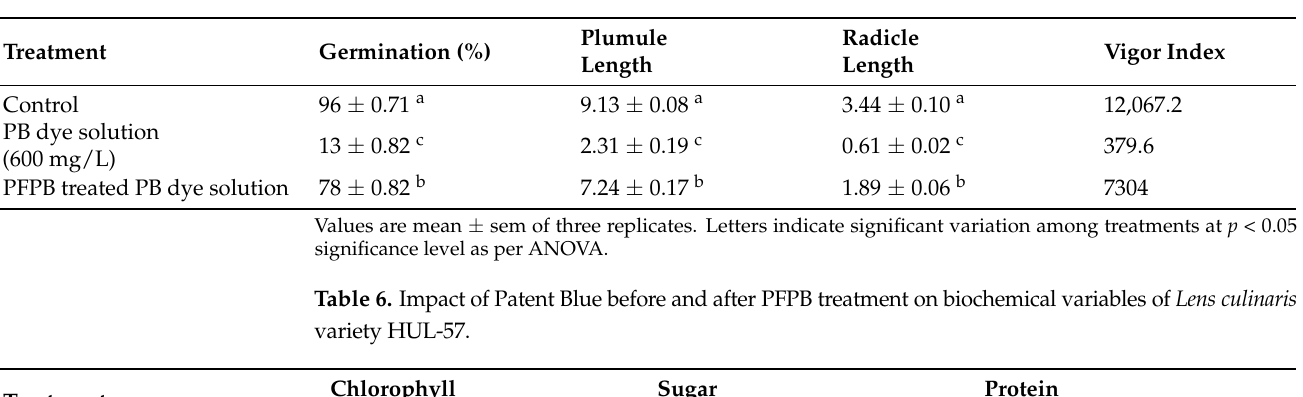
Figure 7. Patent Blue dye elimination by pineapple fruit peel biochar for up to five successive cycles. Table 5. Impact of Patent Blue before and after PFPB treatment on the development of Lens culinaris variety HUL-57.